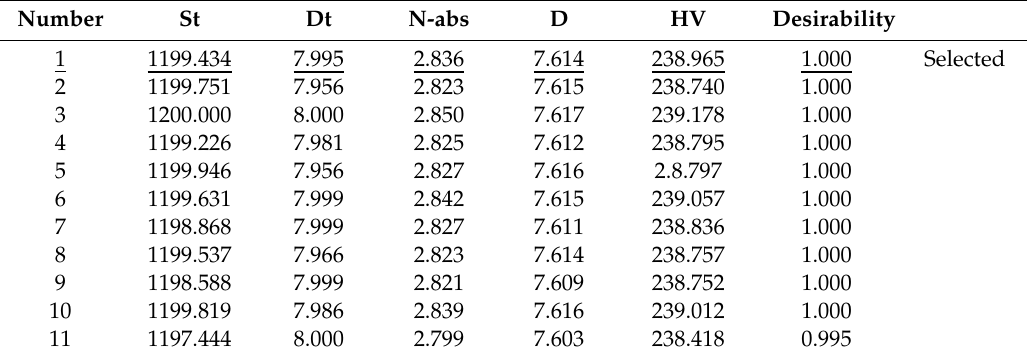
Table 14. Suggested solutions for maximum output.